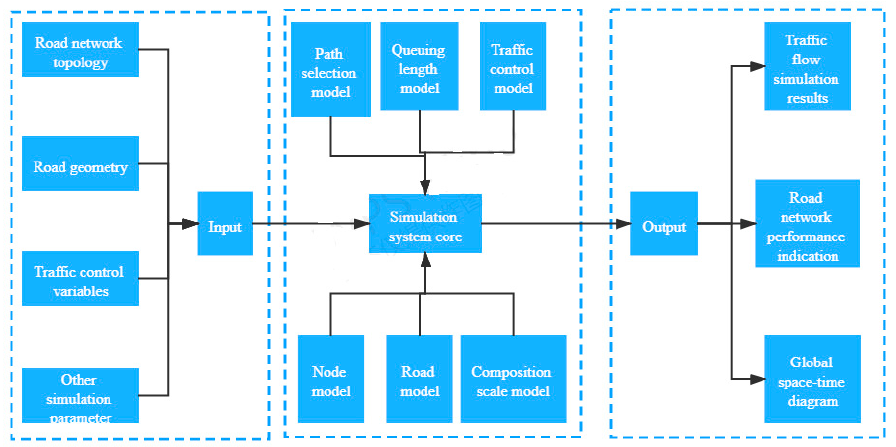
Figure 1. Macroscopic traffic model simulation framework.